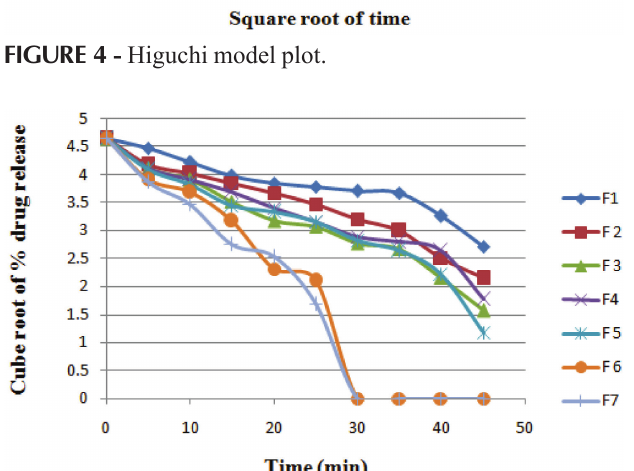
FIGURE 5 Hixon-Crowell model plot.